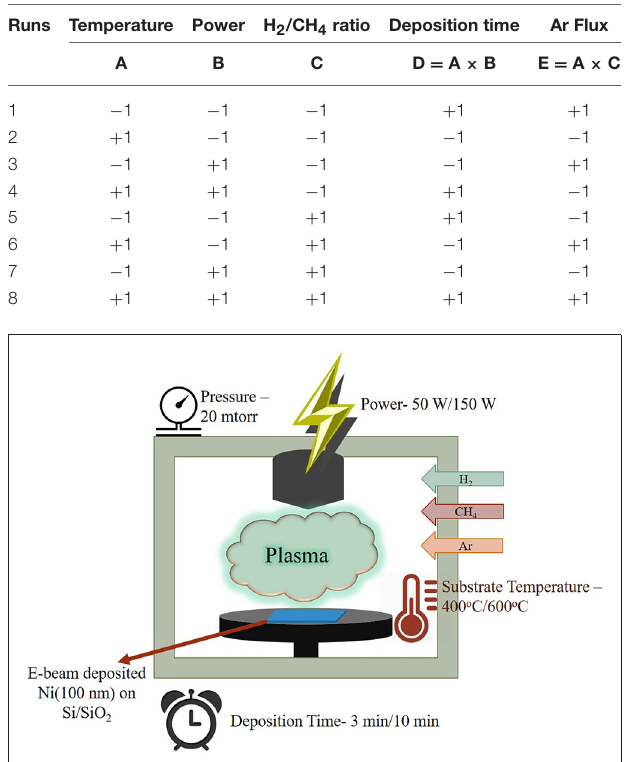
FIGURE 1 | Schematic of PECVD chamber for Graphene synthesis. 100nm of Nickel film on Si/SiO 2 substrate is treated with 2 levels of substrate temperature, RF power, H 2 /CH 4 ratio, deposition time, Ar flux in a PECVD chamber. The recipe is adjusted as per the levels chosen for DoE